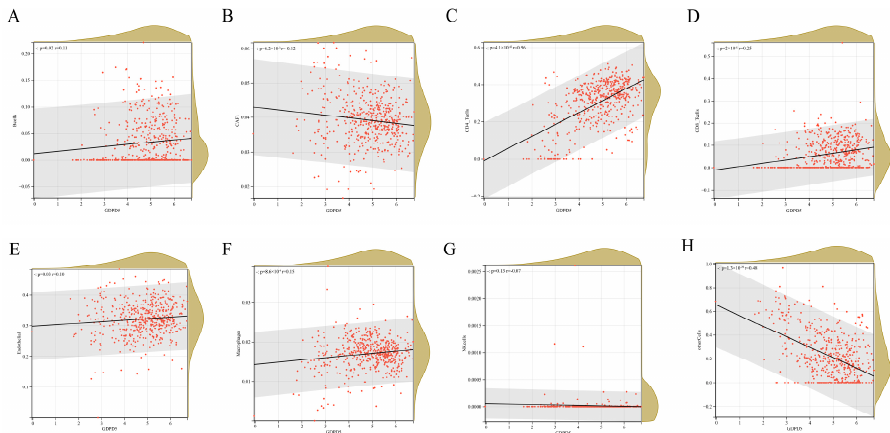
Figure A3. ( A – H ) is the relationship between the expression of GDPD5 and the infiltration of 8 kinds